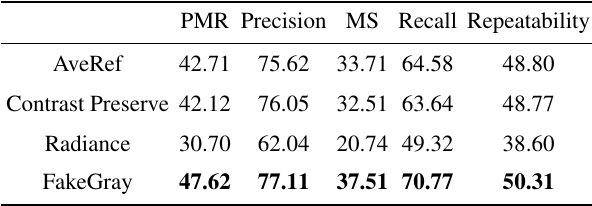
Table 2. Matching Metric for panchromatic keypoints on translation dataset (all data are